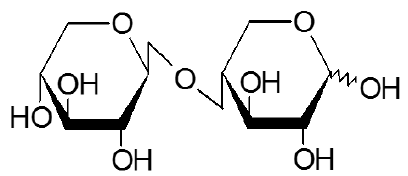
Figure 1. Structure of xylobiose (4 ‐ O ‐β‐ D ‐ Xylopyranosyl ‐ D ‐ xylose).